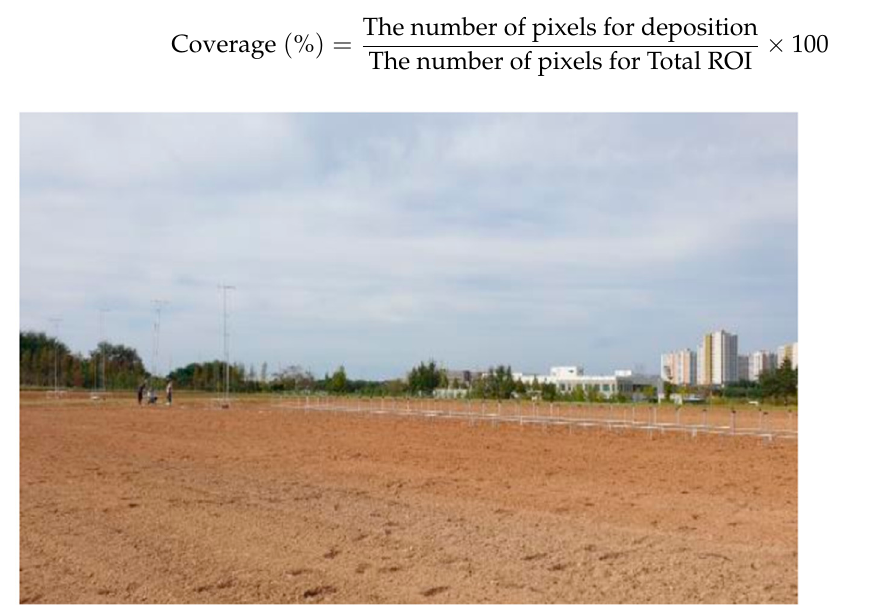
Figure 3. View of test site.